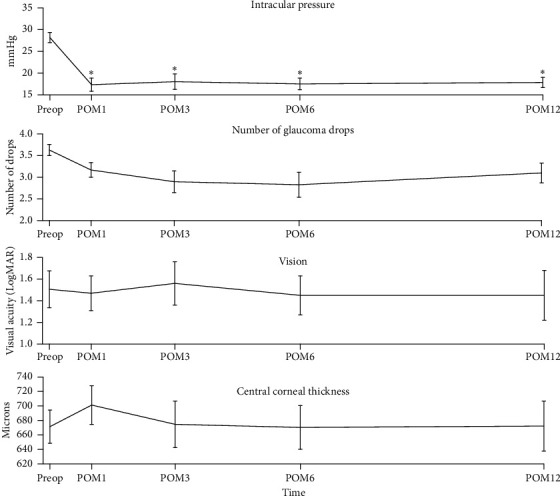
Clinical outcomes following MP-TSCPC in patients with a history of corneal transplant.